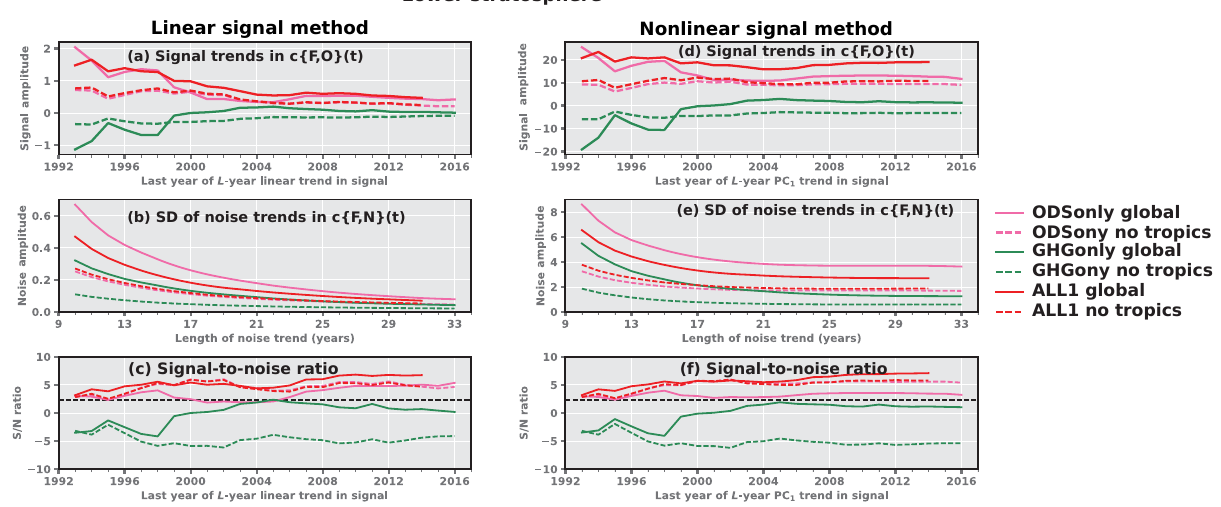
Figure 8. Same as Fig. 7 but for the lower stratosphere. The solid line shows results for the global lower stratosphere, while the dashed lines exclude the tropics (30 ◦ S to 30 ◦